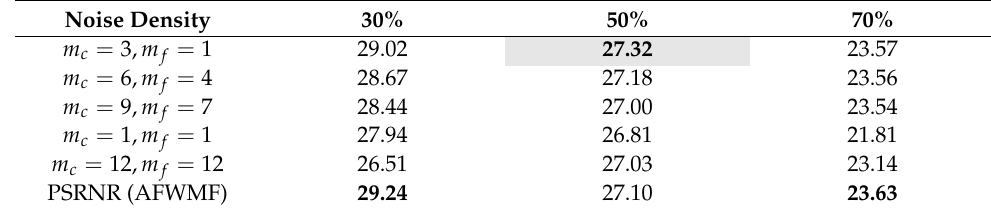
Table 15. The PSNR value for setting parameters by referring to the PSRNR formula (Peppers image). Noise Density